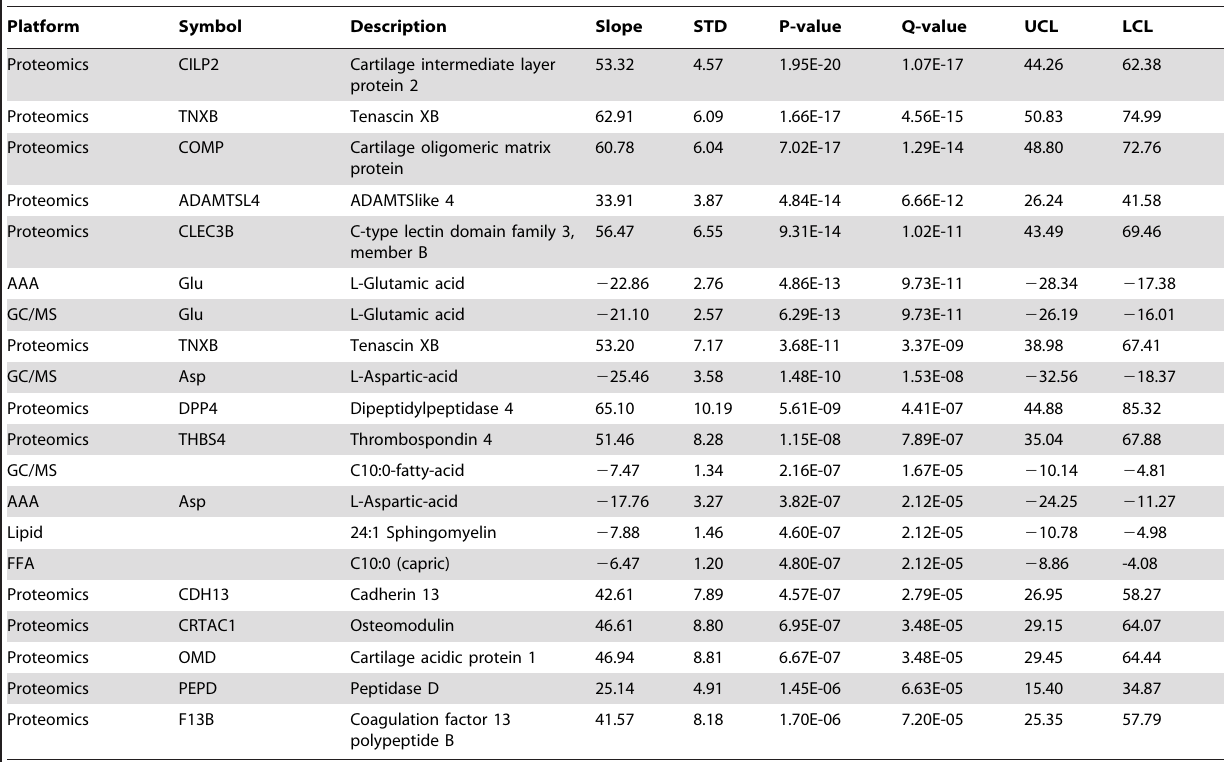
Table is ordered by lowest to highest Q-values. Only plasma markers are represented, as these were the markers with the lowest Q-values. Unknown metabolites were removed from this summary table but the full plasma and urine metabolite and proteomic datasets are available in the Tables S3, S4, S5. AAA – Amino acid analysis; FFA – Free fatty acid; Q-VALUE – significance corrected for the effect of multiple comparisons; STD – Standard deviation; UCL – Upper 95% confidence limit; LCL – lower 95% confidence limit (on the value of slope). Slope values are given as positive and negative (-) values. *These are distinct isoforms detected by the LC/MS method.